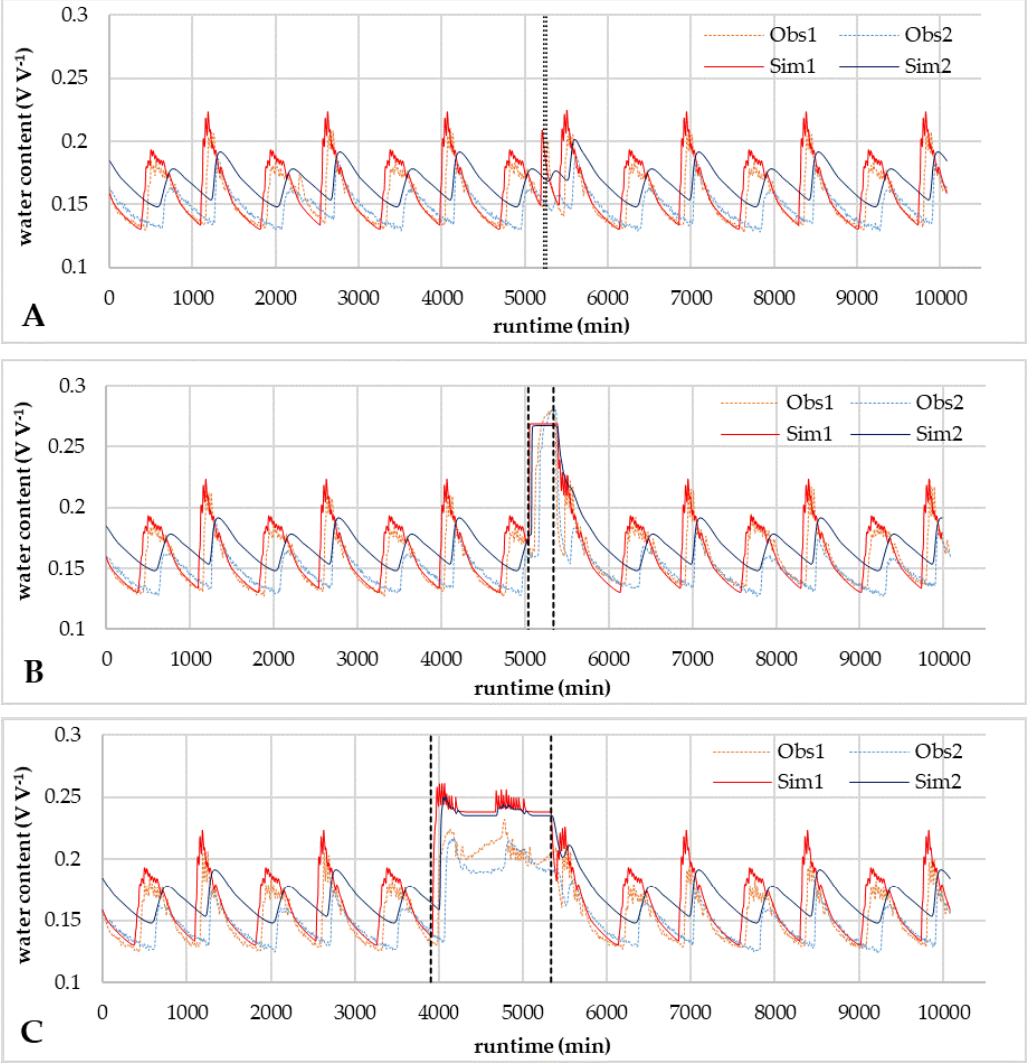
Figure 2. Observed and simulated water contents before, during, and after precipitation event 1 ( A ), event 2 ( B ), and event 3 ( C ) for soil 1 for the upper (Obs1 and Sim1) and lower (Obs2 and Sim2) observation points.